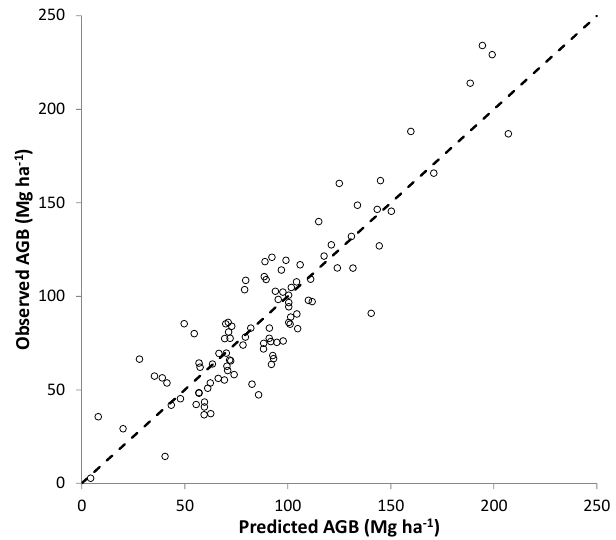
Figure 9. Observed versus predicted AGB obtained using the MARS model fitted to the spectral data corrected using the 6S algorithm. The broken line corresponds to the diagonal.